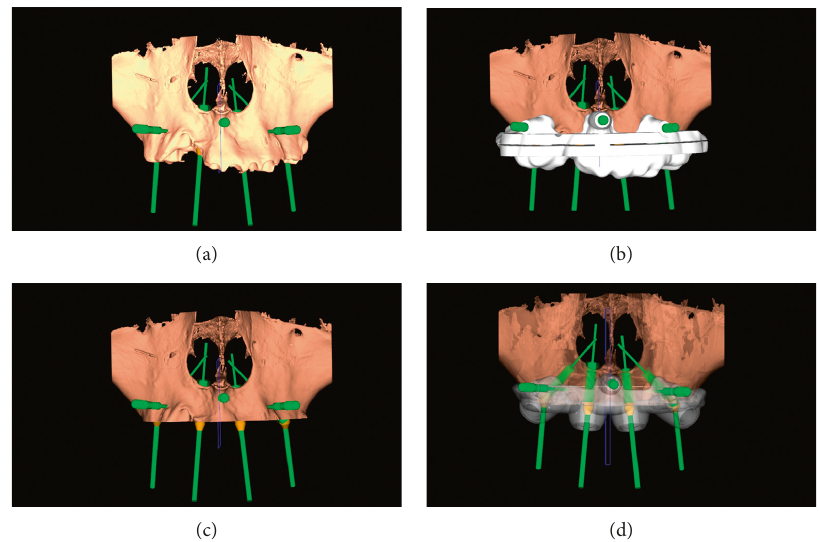
Figure 1: (a) 3D implant planning. (b) Resection guide. (c) 3D implant planning with ostectomy performed. (d) Implant